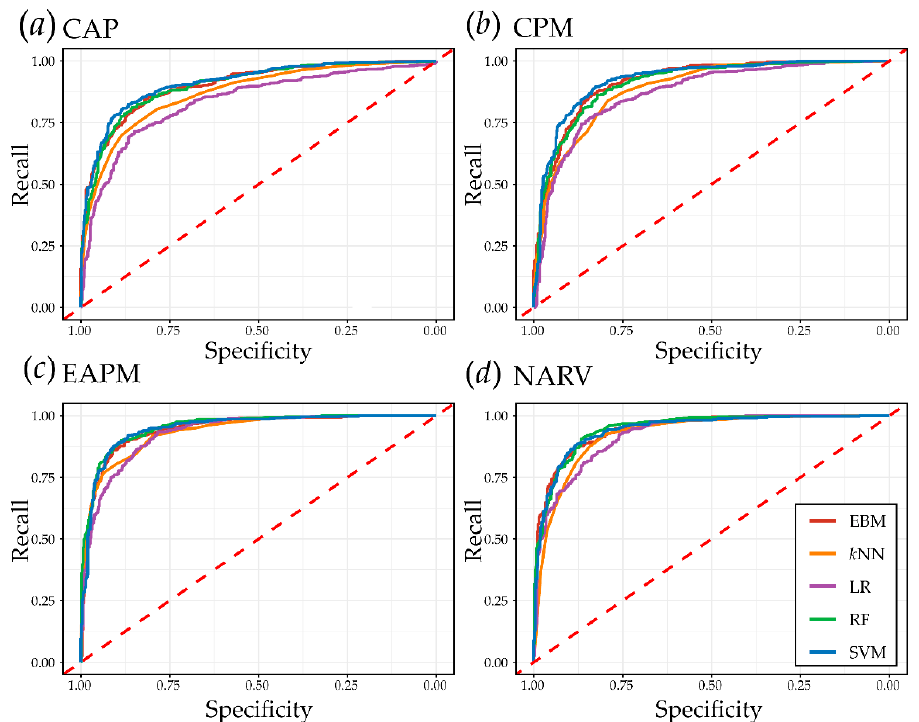
Figure 5. Receiver operating characteristic (ROC) curves for all five models in each of the four MLRA study areas. Associated AUC ROC values are provided in Table 4. ( a – d ) provide results for the CAP, CPM, EAPM, and NARV MLRAs, respectively.